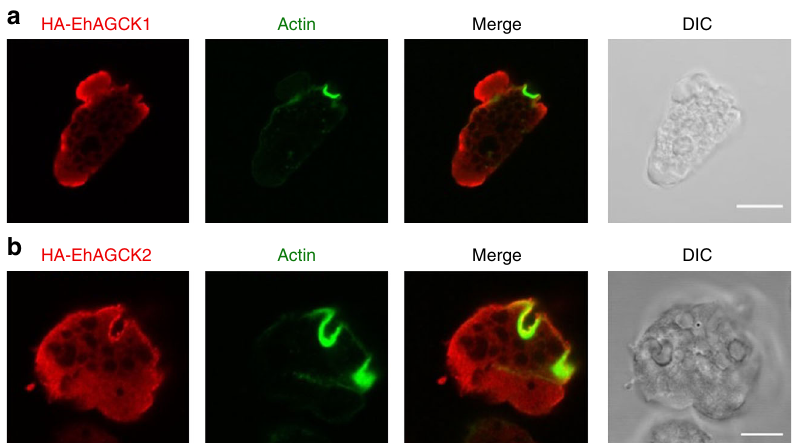
Fig. 3 Immunolocalization of N-terminal HA-tagged protein in fi xed trophozoites. a HA-tagged EhAGCK1 and b HA-tagged EhAGCK2-expressing trophozoites were fi xed and stained for tagged protein and actin. The cells were double labelled with Alexa 546 (EhAGCK1 or EhAGCK2) and FITC-phalloidin (actin). ( Scale bar , 10 μ m; DIC differential interference contrast)